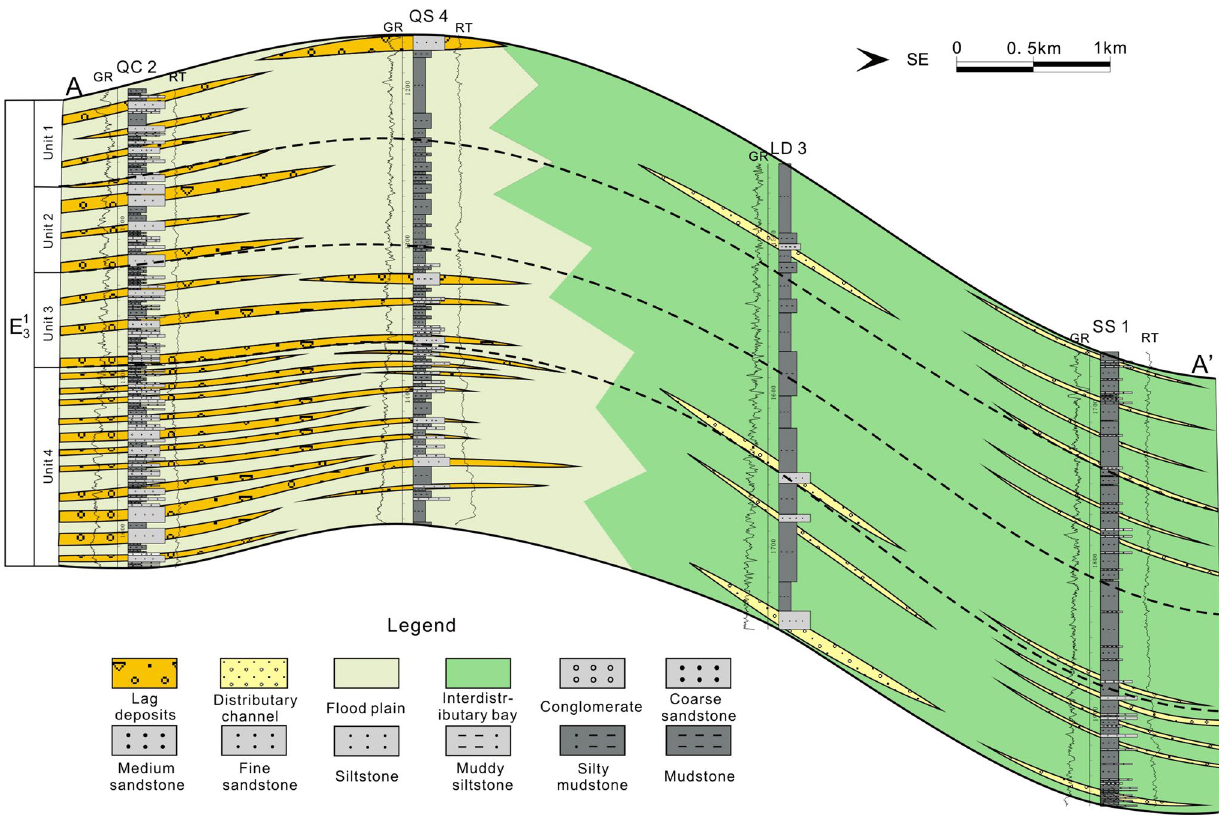
Fig. 6 Stratigraphic correlation section from well QC2 to well SS1 showing distribution of sedimentary facies in the Oligocene Lower Xia- ganchigou Formation (E 31 ) in the Lengdong area, Qaidam Basin, China. The site of the section is marked in Fig. 2a